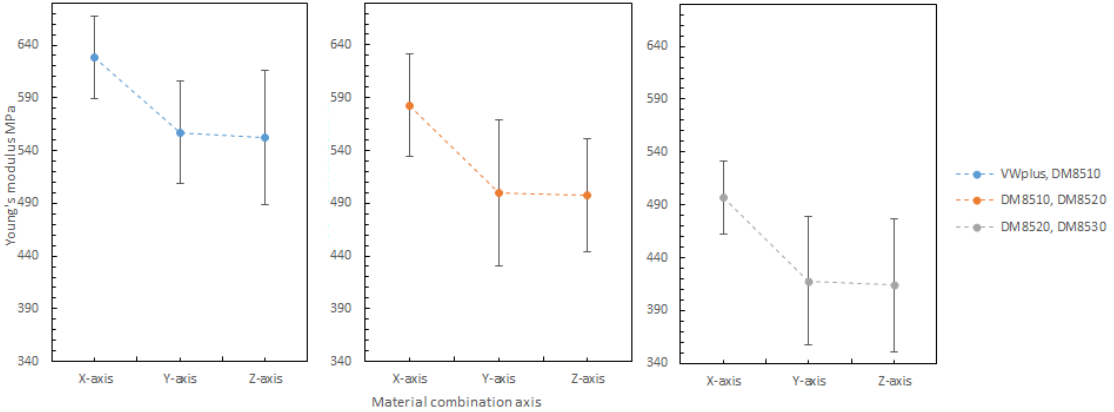
Figure 33. Folding line 3.